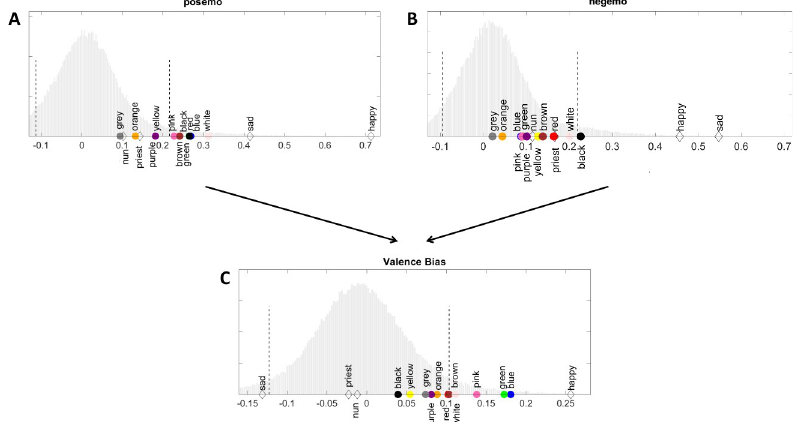
Fig 2. Valence bias. Distributions of similarity scores to the concepts of posemo, denoting positively laden words, (A) and negemo, denoting negatively laden words, (B) as well as valence biases (C) of colour terms, anchor words, and 100,000 most frequent words in our corpus. Colour terms and anchor words are marked with appropriate colours. Dashed lines indicate the 5 th and 95 th percentiles of the distributions (for exact values, see Table